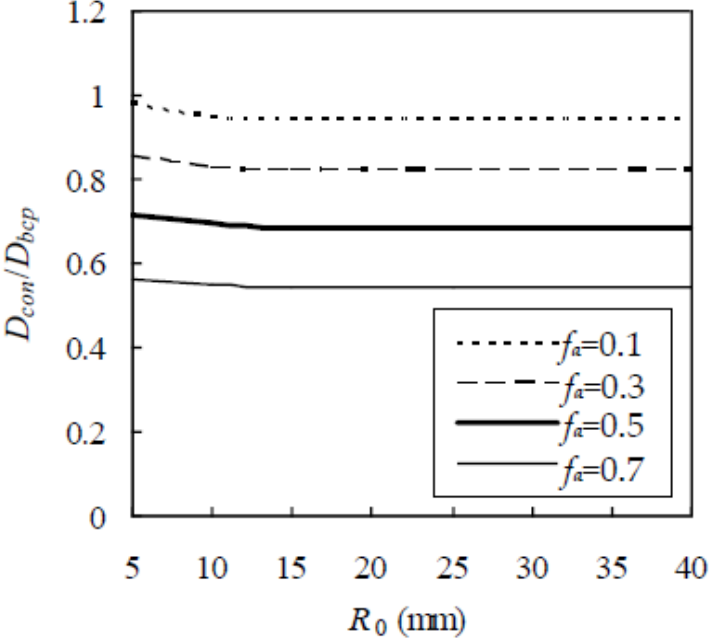
Figure 10. E ff ect of R 0 on chloride di ff usivity of concrete. Figure 10. Effect of R 0 on chloride diffusivity of concrete.